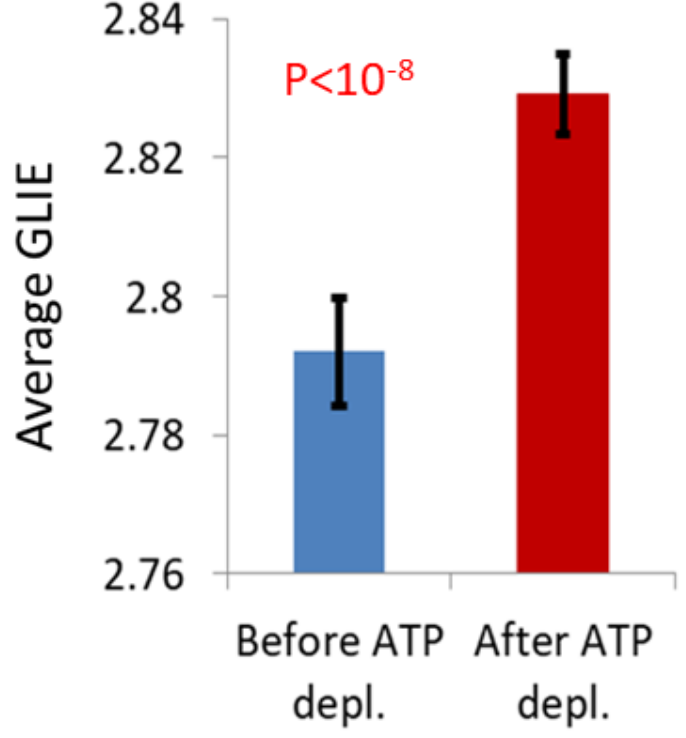
Figure 8. Average GLIE values (the detailed way of calculating average GLIE values is described in Material and Methods section) in the group of Jurkat cells (n = 34) before ATP depletion, in comparison to average GLIE values in those cells after ATP depletion. Error bars are SEM, and p -value for the difference between results is presented.